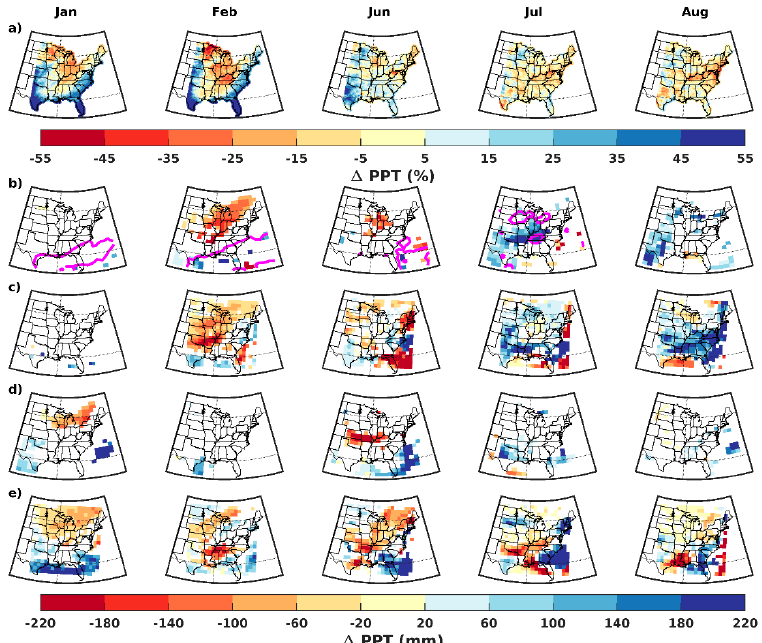
Figure 5. Monthly mean precipitation differences (in mm) differenced by ENSO phase (strong El Niño - weak La Niña) for the ( a ) NOAA ENSO Climate Normals dataset [10] (NB: in % deviation from the long-term mean), ( b ) HadGEM2 output for e.g. January 1985 minus January 2000 (colors: the magenta contours show the areas with +10 mm differences for all events (strong El Niño - weak La Niña) in the entire historical period (1979–2009)), ( c ) HadGEM2-WRF historical climate simulation output re-gridded to the HadGEM2 model resolution, ( d ) HadGEM2 model output for the two matching WRF future simulated years, and ( e ) the HadGEM-WRF future climate simulations re-gridded to the HadGEM2 model resolution. The precipitation anomalies from the HadGEM2-WRF simulations for the historical climate correctly indicate relative drying over the Midwest during winter (Figure 5a–c) under strong El Niño conditions. For the years simulated in the historical climate, the difference in monthly total PPT values during February is lower by up to 100 mm in the strong El Niño versus weak La Niña year across much of the Midwest and Northeast in the HadGEM2-WRF output and is lower by 25% (strong El Niño versus weak La Niña) in the NOAA ENSO Climate Normals. The model chain HadGEM2-WRF manifests larger